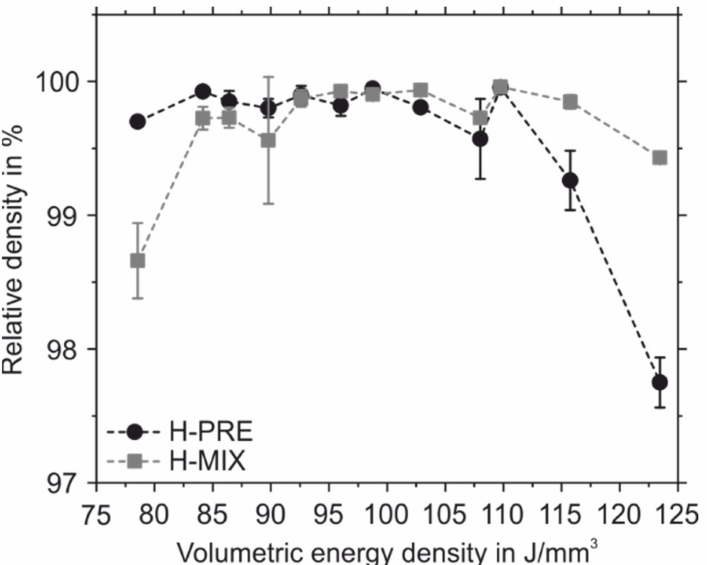
Figure 11. Relative densities of PBF-LB/M samples plotted against the applied volume energy density for H-PRE and H-MIX.